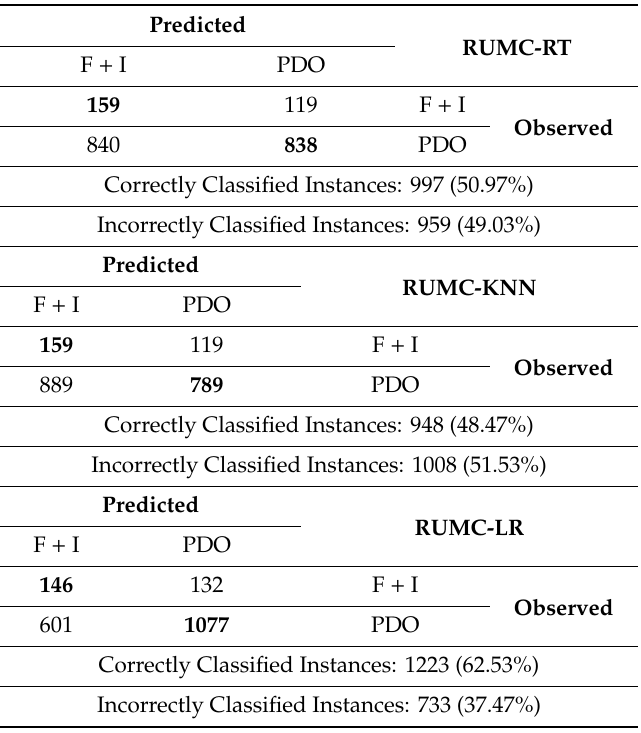
Table 8. Confusion matrices of the classifiers: RUMC-RT, RUMC-KNN, RUMC-LR, and RUMC-RF.